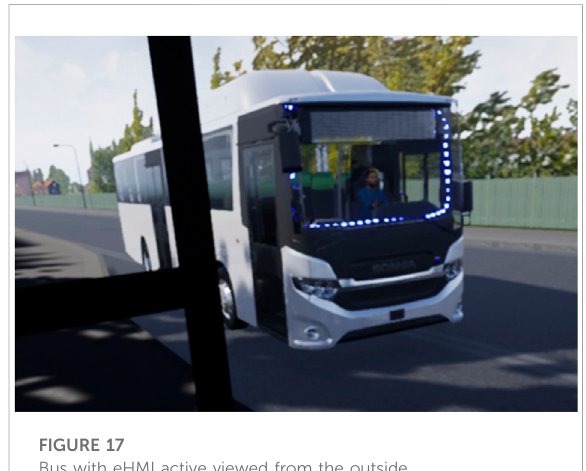
FIGURE 17 Bus with eHMI active viewed from the